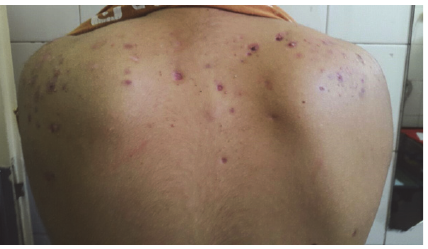
Figure 2: Some papules, pustules, small hemorrhagic crusts, and scar formation were scattered on the upper back of patient with acne fulminant.